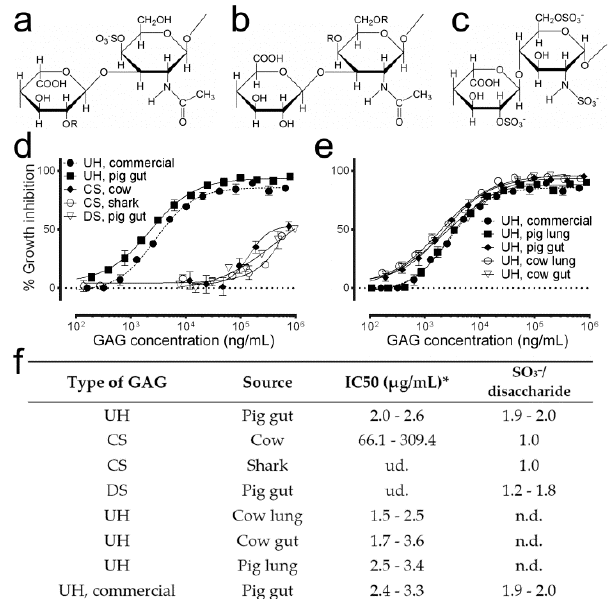
Figure 1. In vitro antimalarial activity of glycosaminoglycans (GAGs) from different origin. ( a – c ) Structures of the most represented disaccharide units in ( a ) dermatan sulfate, ( b ) chondroitin sulfate and ( c ) heparin. R: H or SO 3 ‒ . ( d , e ) Graphs comparing the in vitro Plasmodium falciparum growth